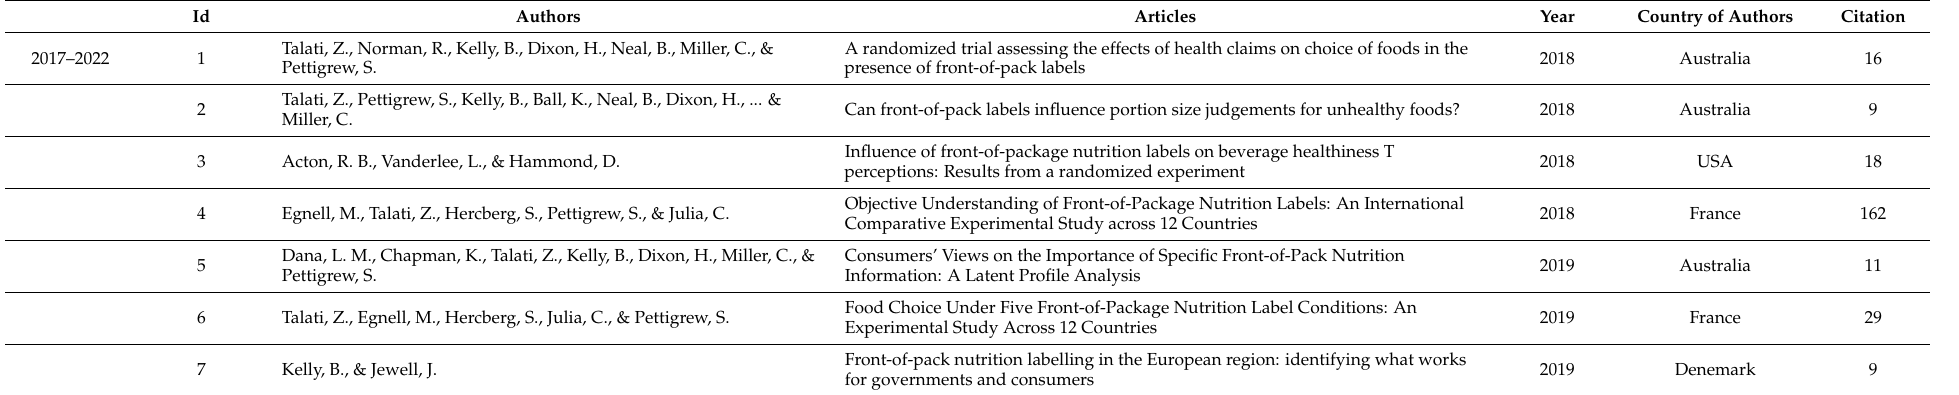
Table 14. Composition of co-citation network 5 in terms of authors, articles, year, country of authors and citation.